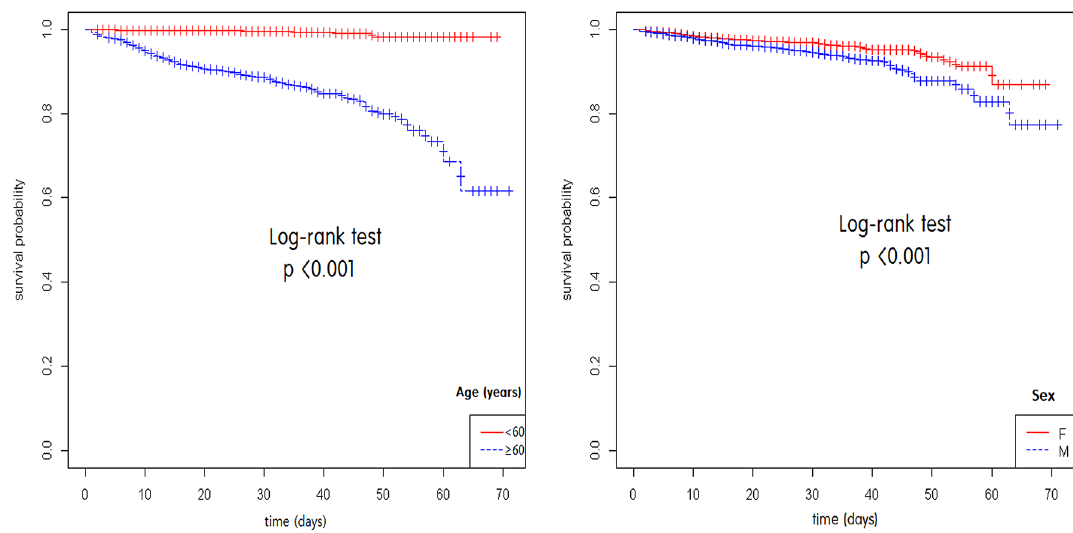
Figure 2. Kaplan–Meier survival curves stratified by age ( a ) and sex ( b